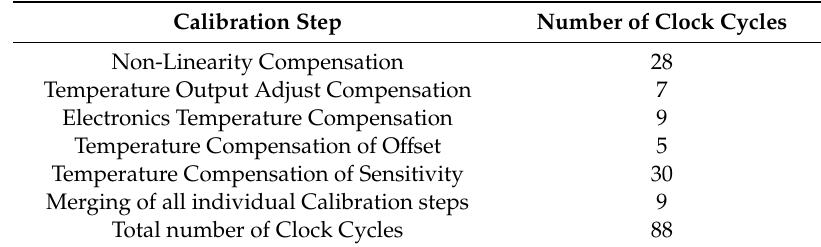
Table 4. Breakdown of all calibration steps in terms of the number of clock cycles on the TMS320F28379D 200 MHz